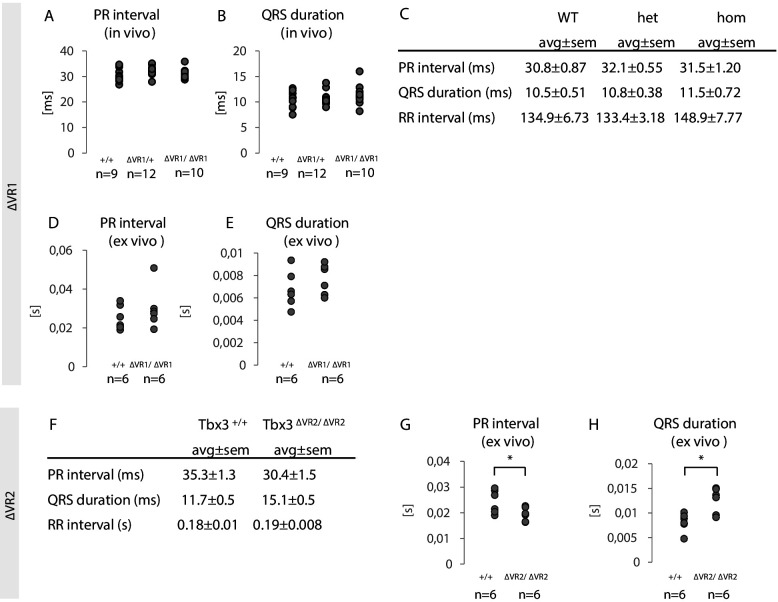
Characterization of Tbx3ΔVR1/ΔVR1 and Tbx3ΔVR2/ΔVR2 mice.(A,B) PR interval and QRS duration in Tbx3+/+ (WT; n = 9), Tbx3ΔVR1/+ (het; n = 12) and Tbx3ΔVR1/ΔVR1 (hom; n = 10) mice measured by surface ECG. No significant difference between the different genotypes was observed. (C) Average values for PR interval, QRS duration and RR intervals for Tbx3+/+ (WT), Tbx3ΔVR1/+ (het) and Tbx3ΔVR1/ΔVR1 (hom) mice as measured by surface ECG. Values depict average ± standard error of the mean. (D,E) PR interval and QRS duration in Tbx3+/+ (WT; n = 6) and Tbx3ΔVR1/ΔVR1 (hom; n = 6) Langendorff perfused hearts (ex vivo ECG). No significant difference between genotypes was observed. (F) Average values for PR interval, QRS duration and RR intervals for Tbx3+/+ (WT) and Tbx3ΔVR2/ΔVR2 (hom) mice as measured by surface ECG. Values depict average ± standard error of the mean. (G,H) PR interval and QRS duration in Tbx3+/+ (WT; n = 6) and Tbx3ΔVR2/ΔVR2 (hom; n = 6) Langendorff perfused hearts (ex vivo ECG). No significant difference between genotypes was observed.